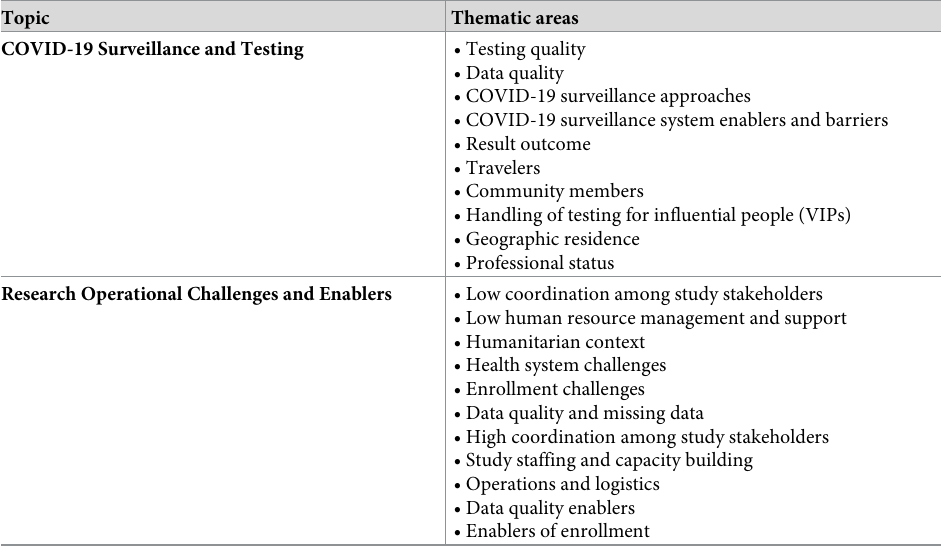
Table 3. Restricted list of topics and thematic areas considered for major